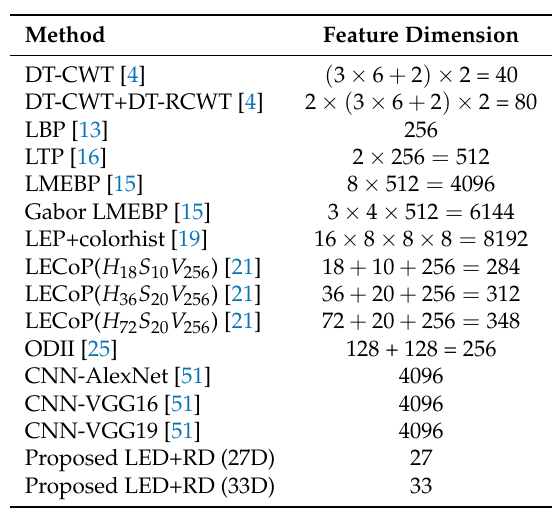
Table 7. Comparison of feature vector length of different